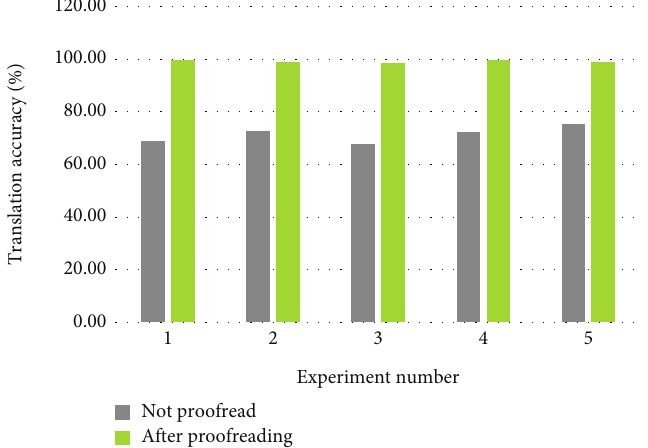
Figure 4: Accuracy comparison before and after participating in the calibration of this method.